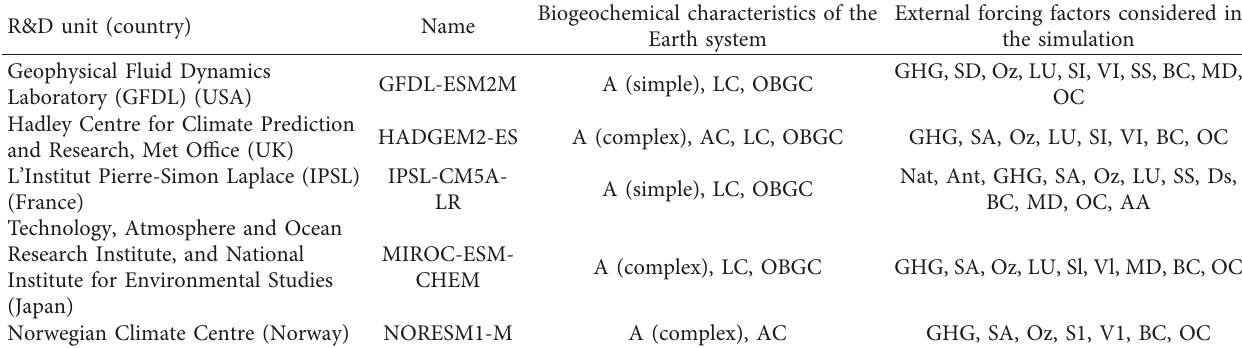
Table 1: Details of five global climate models provided by ISIMIP.